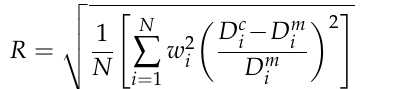
Table 3. A summary of optimized variables of the EoS for solid aluminum. Equation Parameter Value